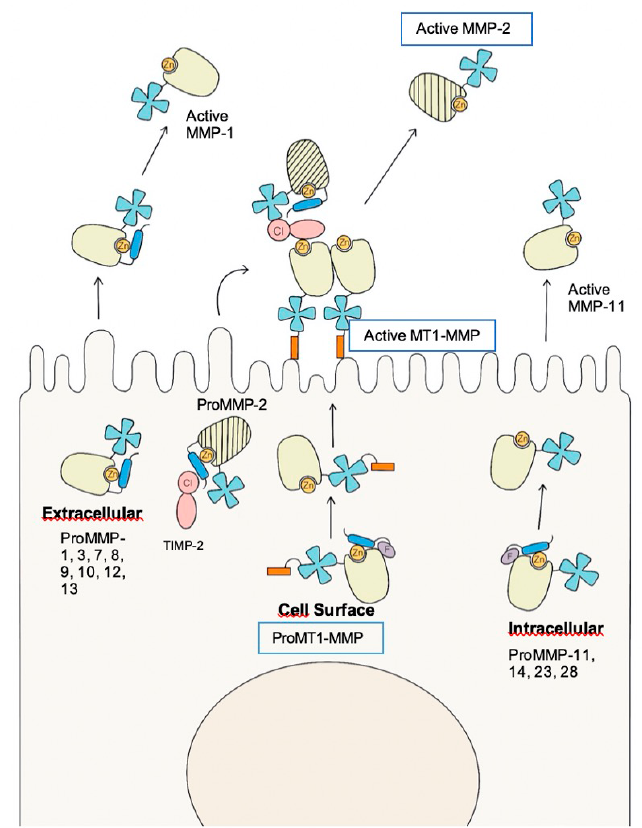
Figure 3. Mechanisms for Pro Matrix Metalloproteinase Activation. ProMMP-2 is the only MMP activated on the cell surface by MT-1MMP (MMP-14); this activation requires the trimolecular complex MT1-MMP / TIMP-2 / proMMP-2 and the dimerization of the MT1-MMP. Extracellular activation